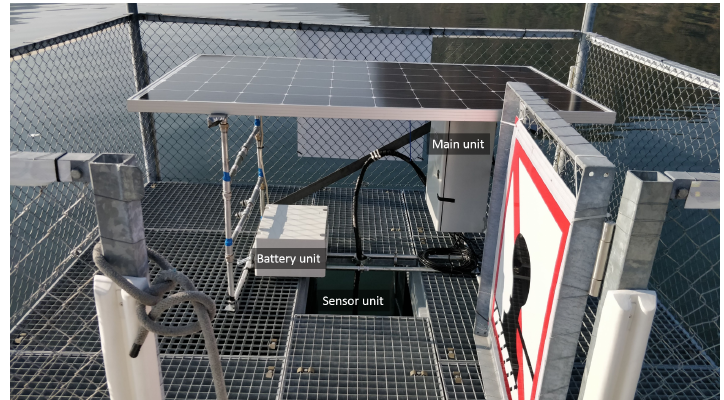
Figure 4. The AHFM system architecture.